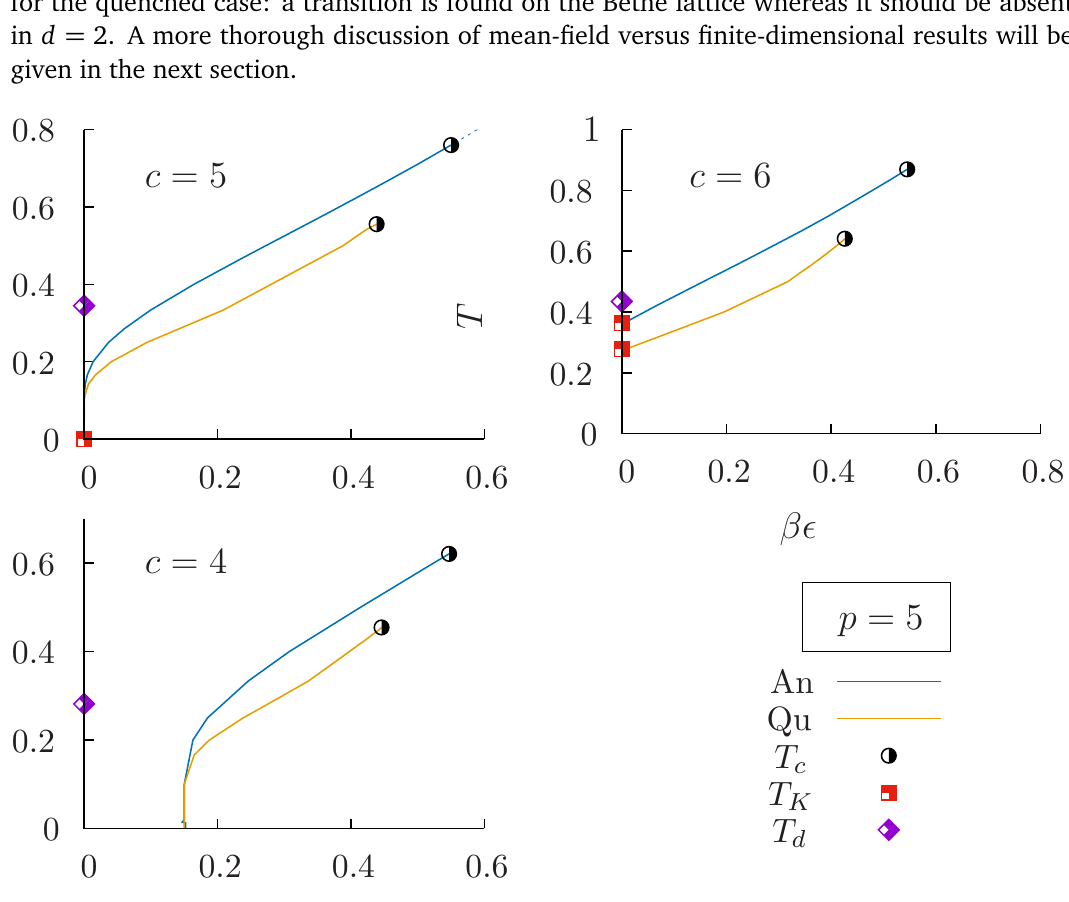
Figure 3: Temperature T versus coupling βε phase diagram for the plaquette spin models with p = 5 in both the annealed and the quenched descriptions on Bethe hyper-lattices with c = 4,5,6. The interaction strength J is set equal to 1. The dashed line is the continuation of the self-dual line (see text). We consider βε instead of ε for the horizontal axis to better compare all cases; otherwise the transition line for c = 4 terminates in ε ∗ = 0 at T = 0, although the situation is quite different from the case c = 5 because there is a nonzero configurational entropy at T = 0 and ε ∗ actually scales as T and not T exp ( − J / T )